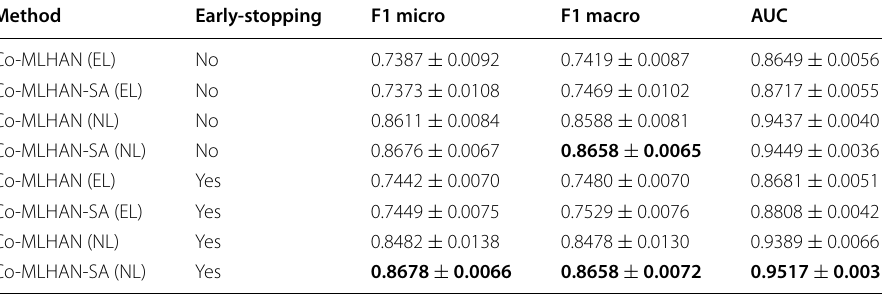
Bold values refer to the best score for each